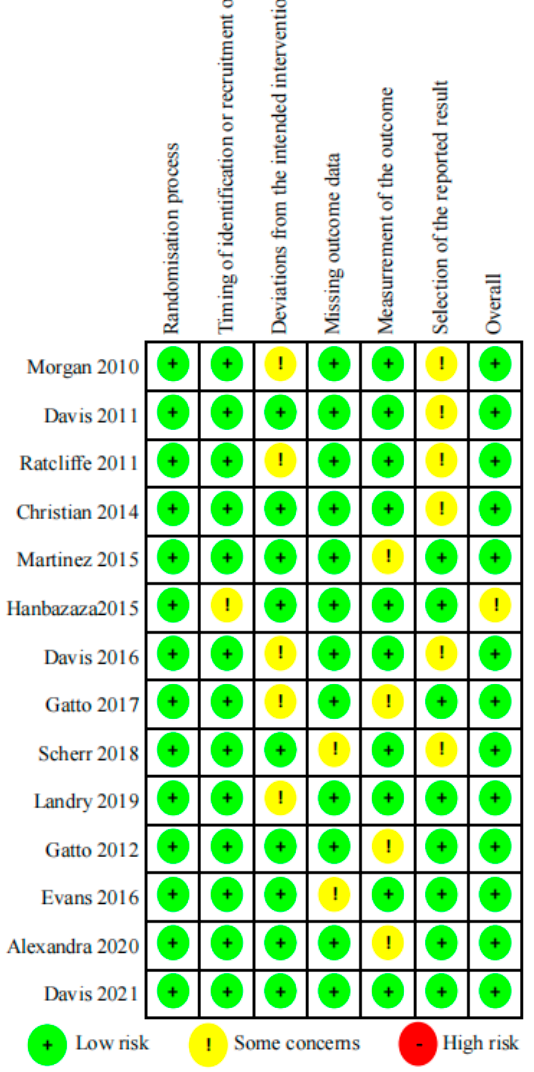
Figure 2. Risk of bias graph per type of bias assessed.